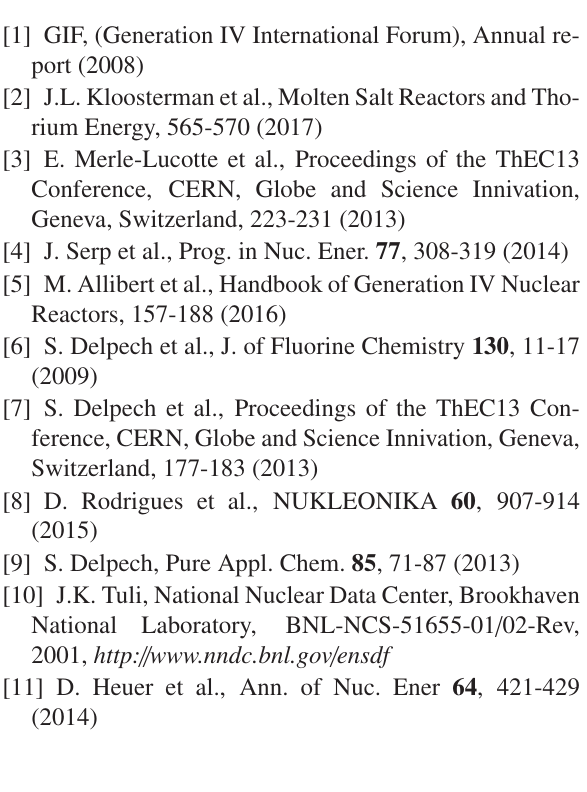
Figure 6. Concrete shielding associated to the gamma radiations